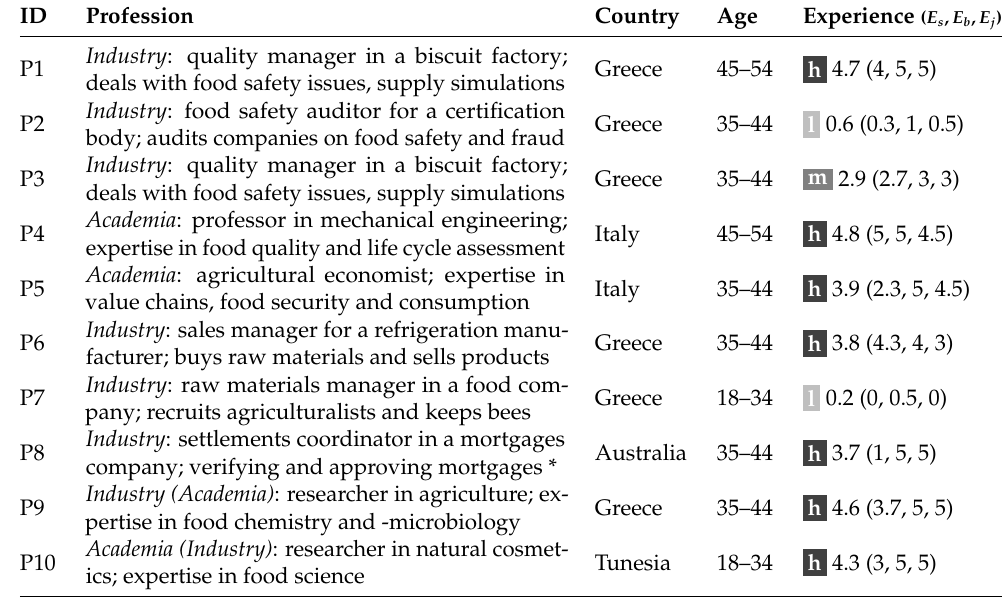
Table 1. Participants’ background information, including their experience with predictive regression ( l low, m medium, h high) as an average of self-reported experience ( E s ), background ( E b ), and jargon use ( E j ). All participants identified as male and had a post-graduate education